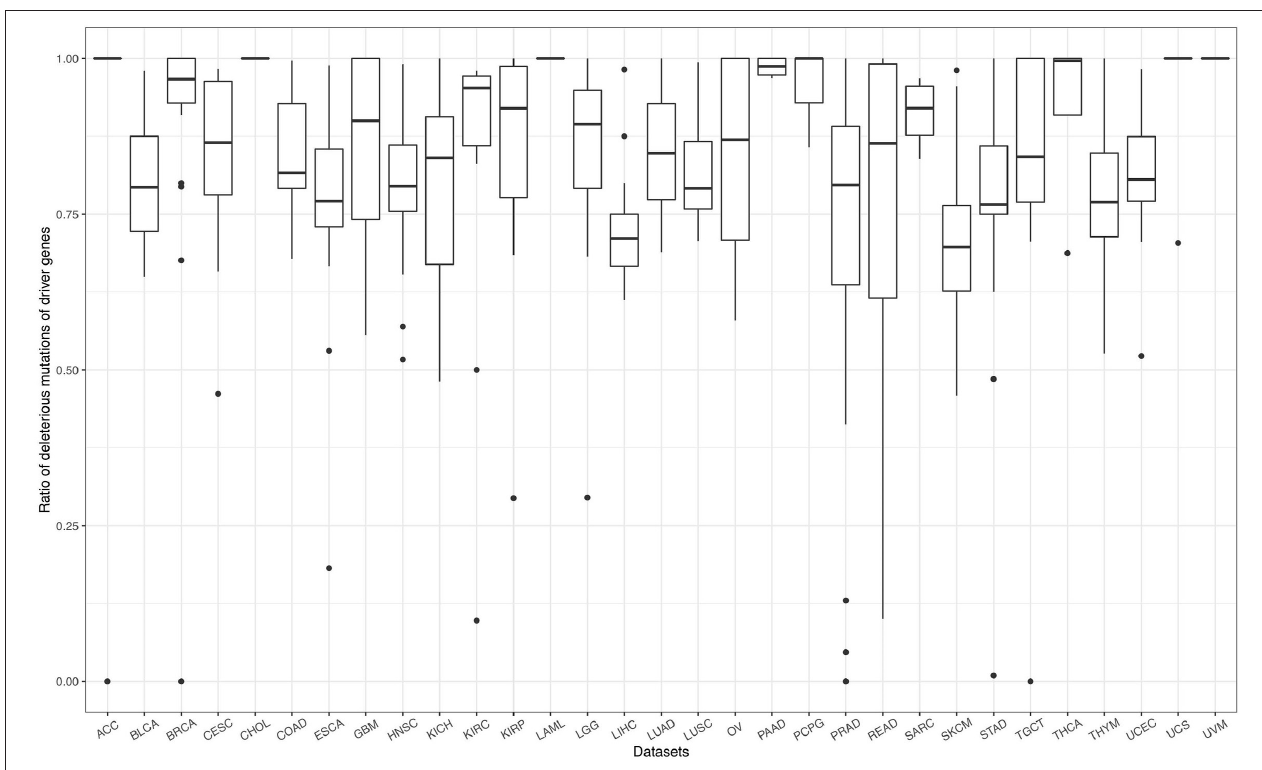
FIGURE 6 | The ratio of non-silent and null mutations (deleterious mutations) to total mutations for driver genes identified by FI-net. Thirty-one boxplots show the ratios of deleterious mutations in all genes identified in 31 datasets, respectively.